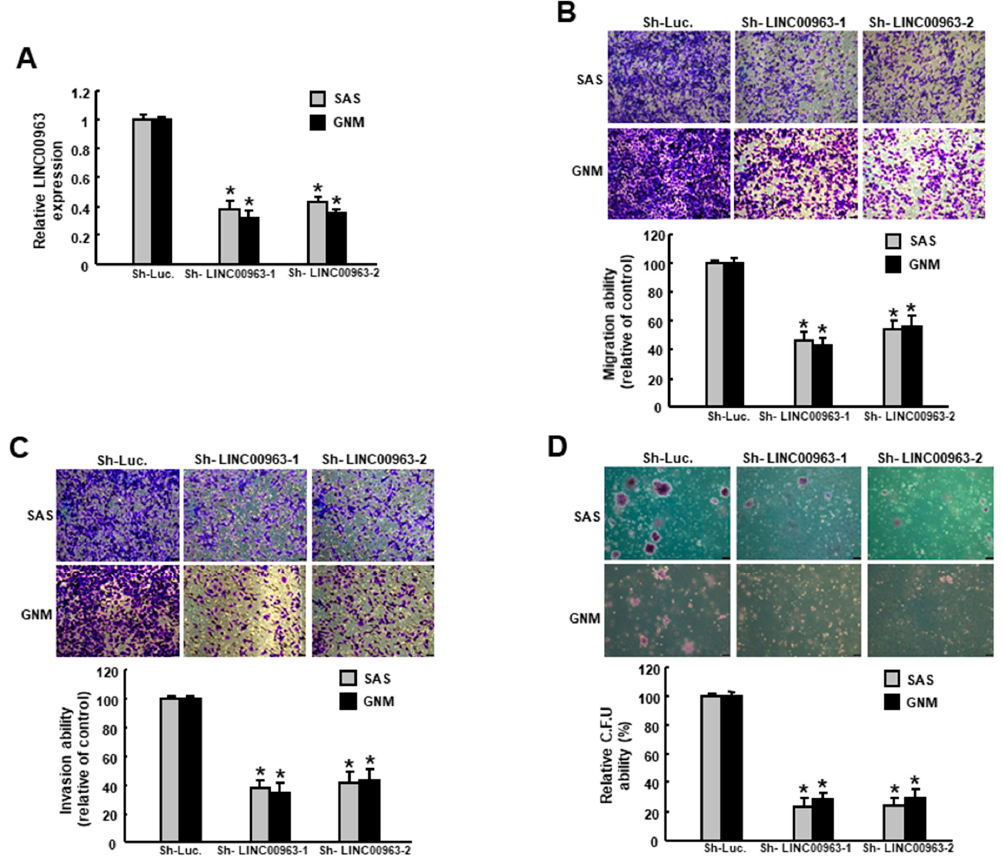
Figure 3. Inhibition of LINC00963 suppresses the stemness phenotypes in OSCC. ( A ) Cells were transfected with lentiviral vectors to inhibit LINC00963; ( B ) migration, ( C ) invasion, and ( D ) colony formation capacities were evaluated. Experiments were repeated three times and representative results were shown. Results are means ± SD of triplicate samples from three experiments. * p < 0.05